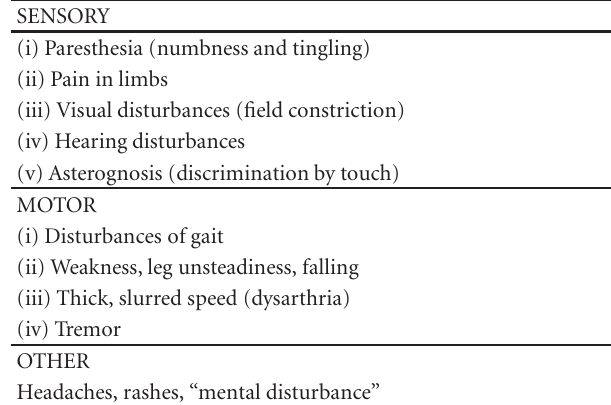
Table 3: Scope of methylmercury poisoning experienced in Japan beginning in the 1950s. This syndrome became known as Minamata Disease. Later, when the e ff ects of prenatal exposure became evident, a new category, Fetal Minamata Disease, was